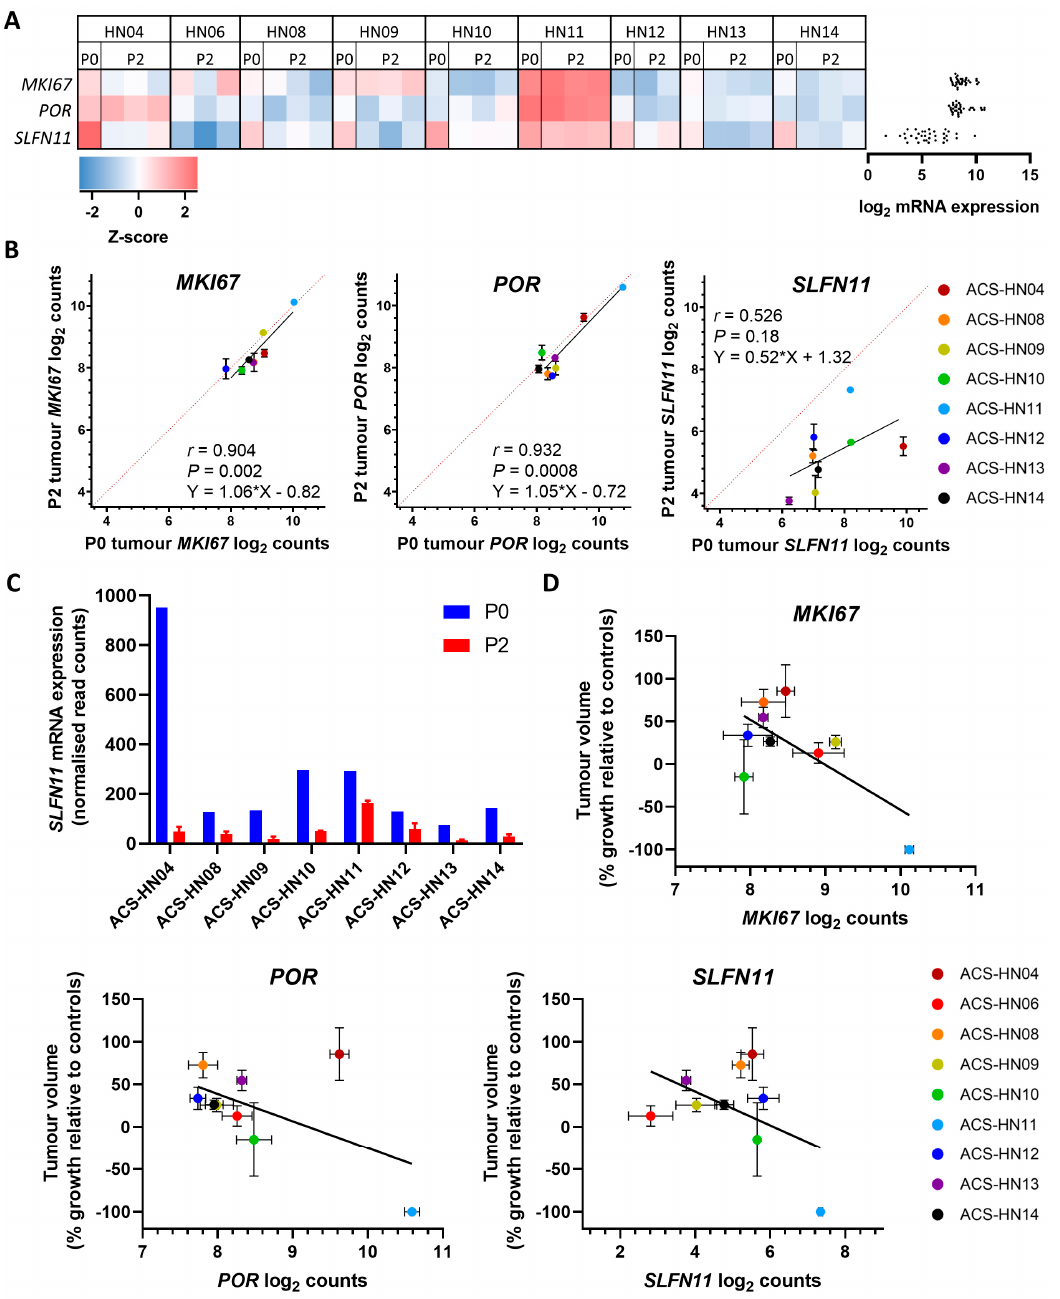
Figure 5. Expression of MKI67 , POR , and SLFN11 in HNSCC PDX models. ( A ) Heatmap of mRNA expression of MKI67 , POR , and SLFN11 genes in P0 and P2 PDX tumours determined as z-score relative to other PDX tumour samples. Red indicates high expression, blue indicates low expression. Gene expression determined as log 2 counts normalised to positive control and three housekeeping genes. Individual counts shown on right. ( B ) Comparison of MKI67 , POR and SLFN11 mRNA expression in P0 ( n = 1) and P2 ( n = 2–3) tumours across eight PDX models. Symbols represent mean ± SEM. Dotted lines represent equal expression. ( C ) SLFN11 expression in P0 and P2 tumours for eight PDX models. Bars represent individual values (P0) or the mean ± SEM for n = 2–3 tumours (P2). ( D ) Comparison between evofosfamide anticancer efficacy (tumour growth in evofosfamide-treated mice relative to controls at end of treatment or endpoint) and MKI67 , POR and SLFN11 expression in HNSCC PDX models. Symbols represent mean ± SEM for n = 2–12 tumours.